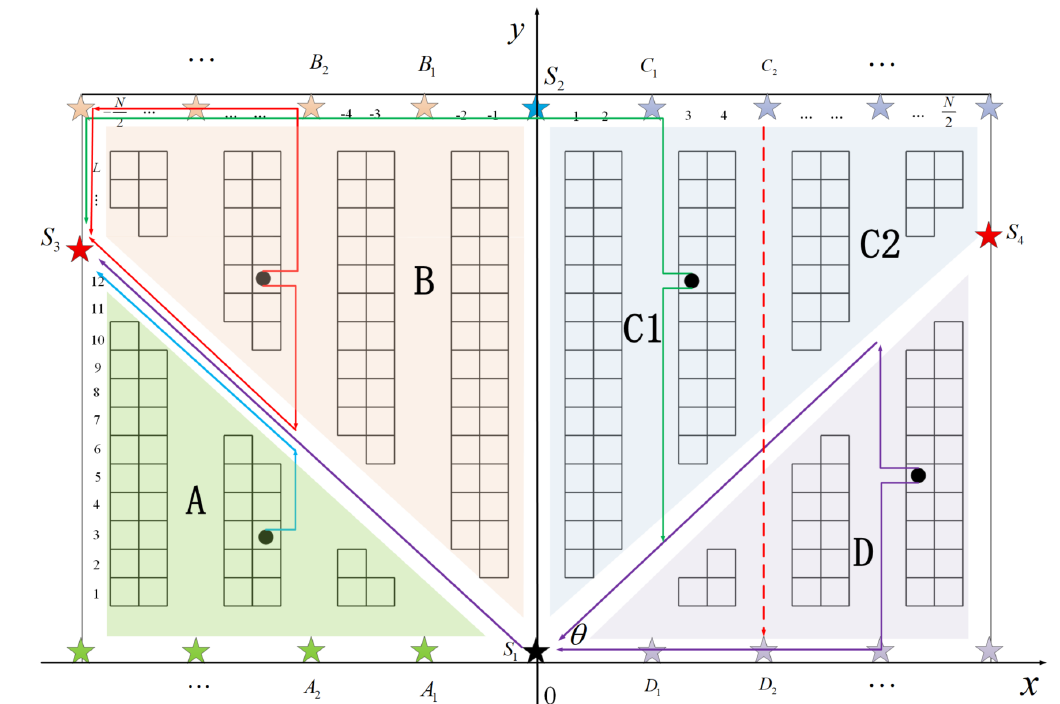
Figure 5. Sketch of flying-V layout with multiple workstations and four divided